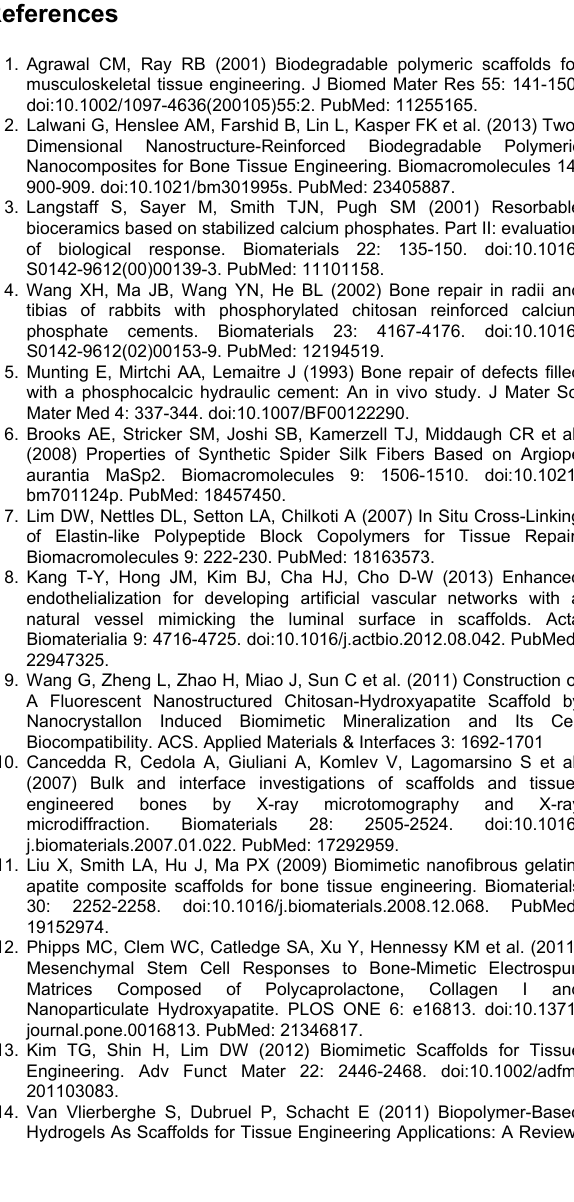
Table S1. Follow-up results of hematology data of various groups during post-operative care.